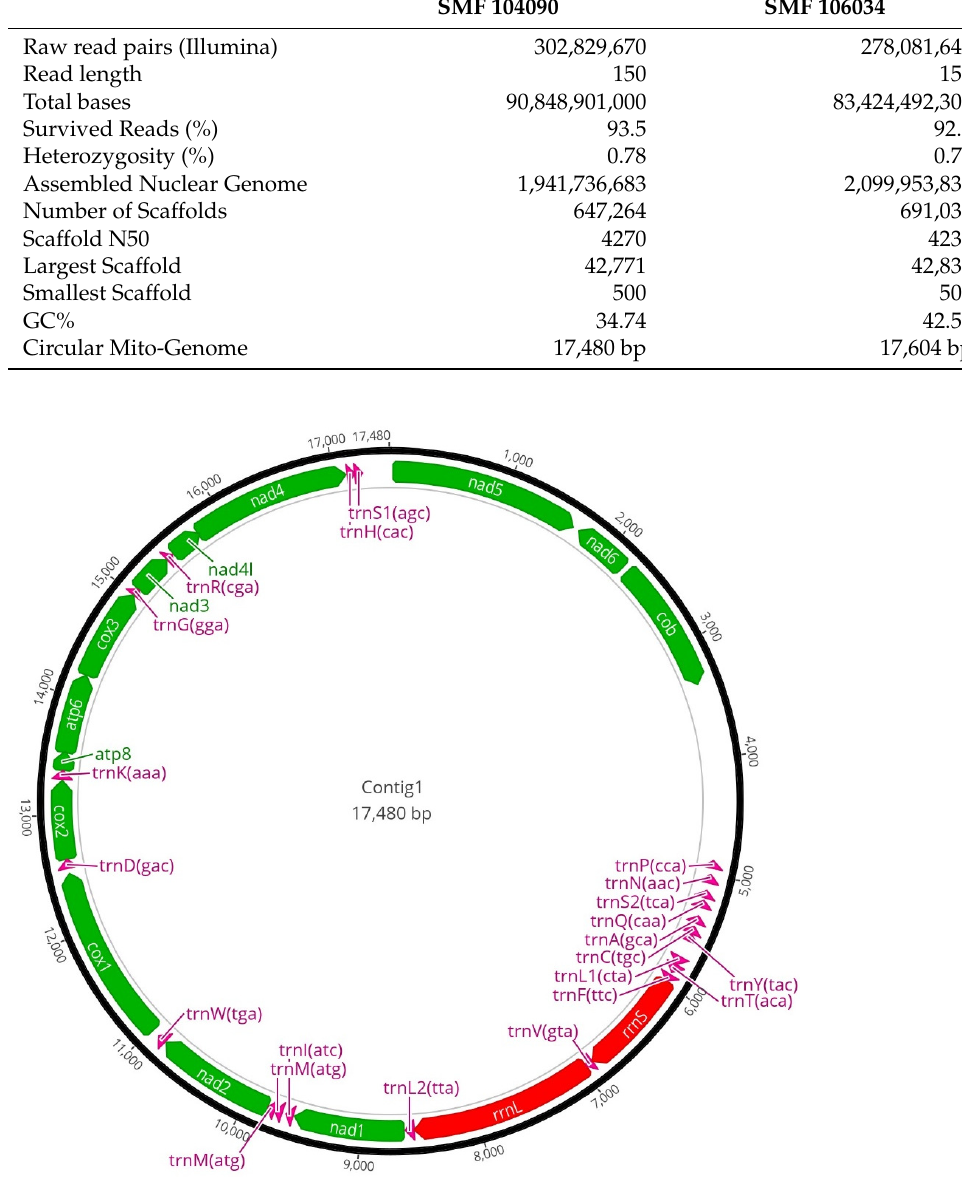
Figure 12. Annotated mitochondrial genome of the holotype of Limnonectes bagoensis n. sp. (SMF 104090) see text for details.